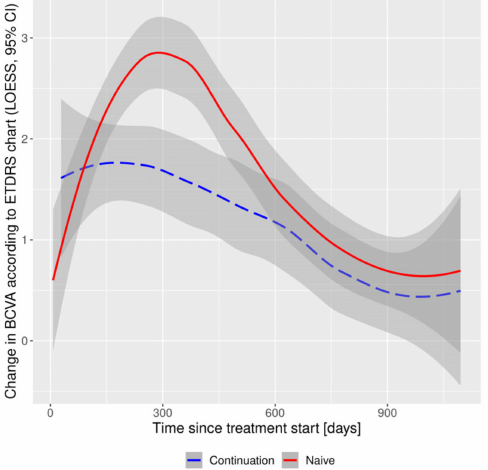
Figure 3. Functional outcomes: changes in Best Corrected Visual Acuity according to ETDRS chart in continuation and naïve subgroups. BCVA, Best Corrected Visual Acuity; CI, Confidence Interval; ET- DRS, Early Treatment Diabetic Retinopathy Study; LOESS, Locally Estimated Scatterplot